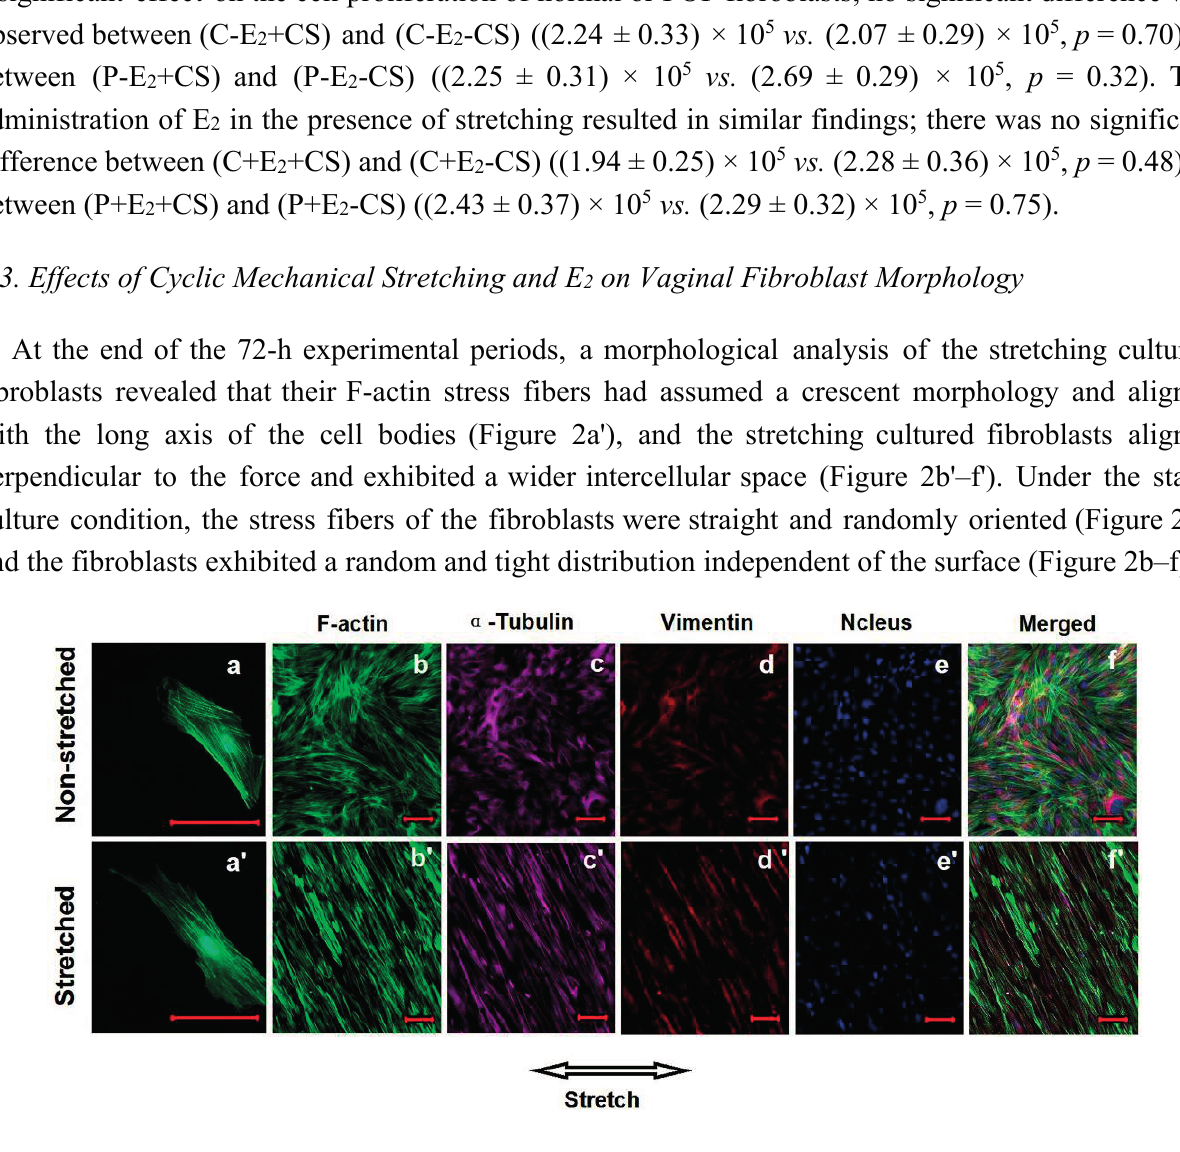
Figure 2. Effects of cyclic mechanical stretching (CS) on the orientations of cytoskeletons and vaginal fibroblasts. The static growth F-actin stress fibers ( a ) and fibroblasts ( b – f ); The stretching growth F-actin stress fibers ( a ') and fibroblasts ( b '– f '). Bar = 100 μ